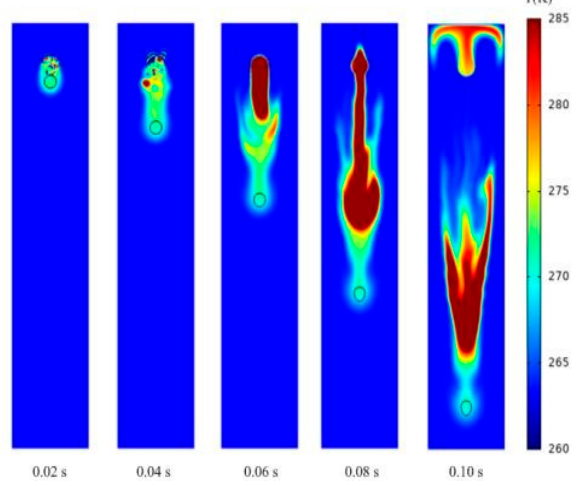
Figure 11. Temperature distribution of a free-falling water droplet in air at 263.15 K.